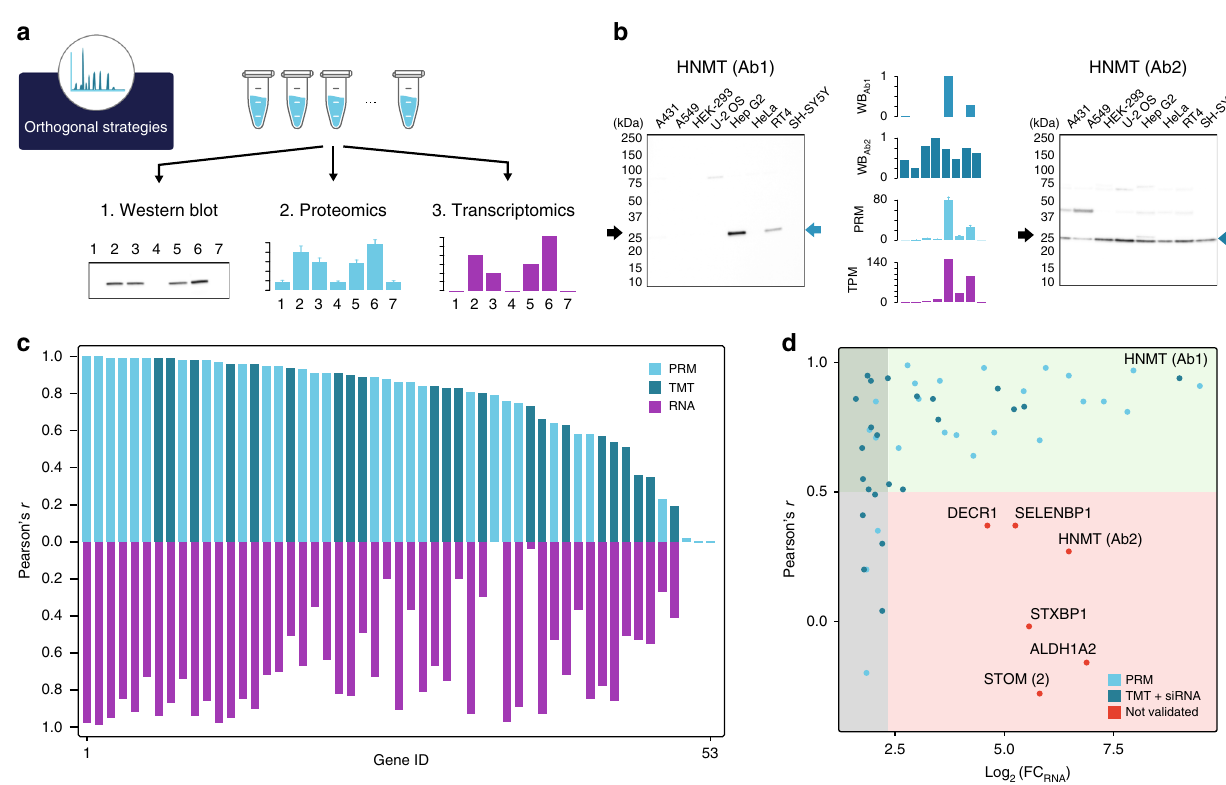
Fig. 2 Orthogonal validation of antibodies using proteomics. a Principle for the Western blot validation strategy based on correlating protein expression levels determined across a panel of cell lines using either proteomics or transcriptomics. b Example of orthogonal validation of Western blot bands (WB, relative intensity) by proteomics (Parallel Reaction Monitoring, PRM) reported as ratio to standard or transcriptomics reported as Transcript Per Million (TPM). Error bars represent 1 s.d. across three technical replicates. The black arrow indicates the theoretical molecular weight of the protein and blue arrows indicate the band subjected for the intensity-based relative quanti fi cation to determine the antibody staining pro fi le. More examples including loading controls are presented in Supplementary Fig. 2 – 3 for PRM and TMT, respectively. c Mirror plot summarizing the Pearson ’ s r for 53 antibodies evaluated either by TMT (dark blue) or by PRM (light blue) including transcriptomics-based validation based on RNA expression (purple). d Analysis of the Pearson ’ s r between Western blot band intensities and RNA expression levels as a consequence of the fold-change between the highest and lowest value across the cell lines. The gray area represents fold-change in RNA levels less than fi vefold. Antibodies in the green area (Pearson ’ s r > 0.5) are considered validated while antibodies in the red area (Pearson ’ s r < 0.5) are considered not